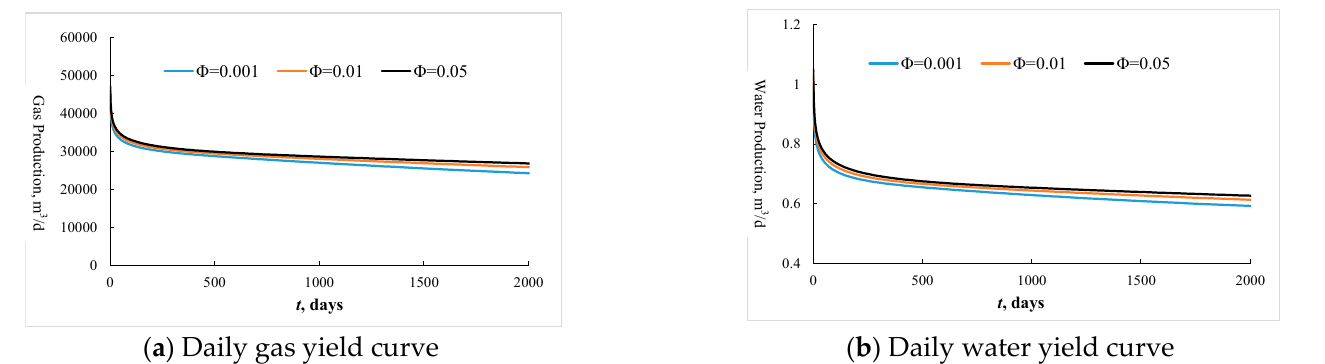
Figure 5. Effects of fracture porosity on the gas and water production rates.